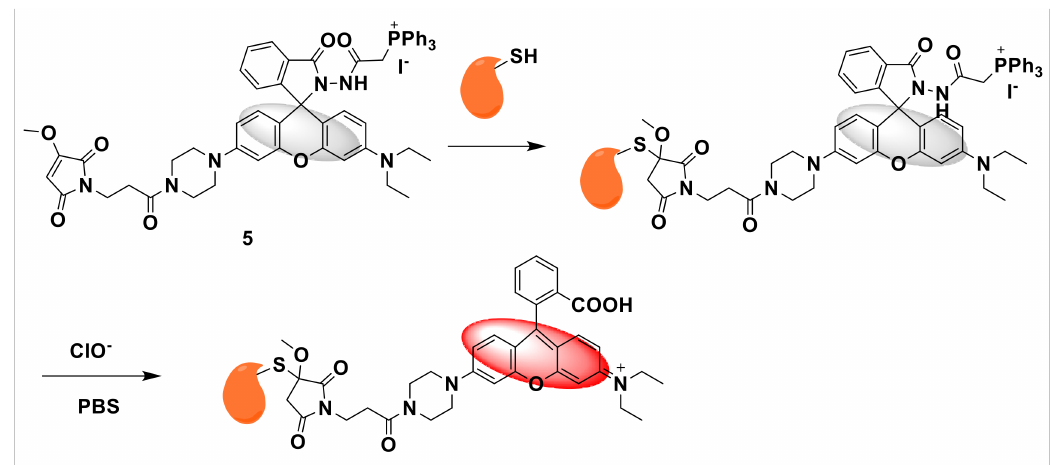
Figure 7. The reaction of probe 5 and ClO −